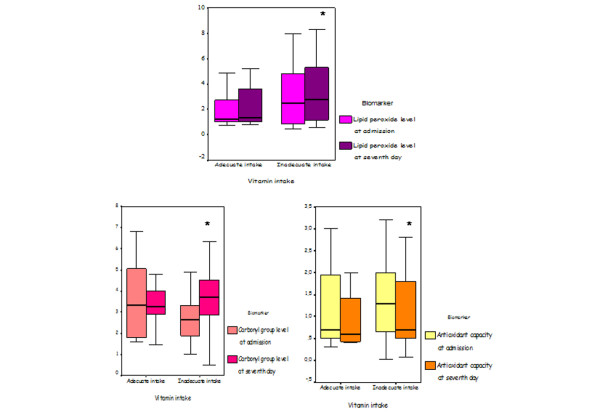
Changes in oxidative stress biomarkers according to vitamin intake.